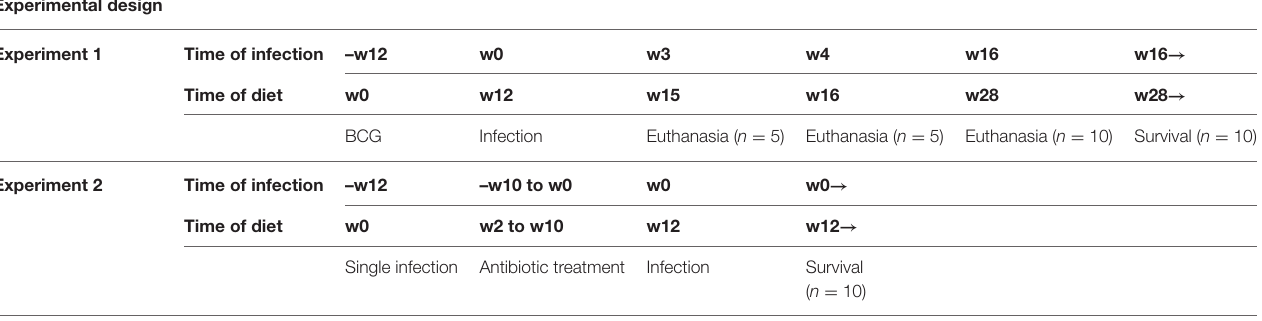
TABLE 1 | Experimental design of both experiments performed in the study. Experimental design